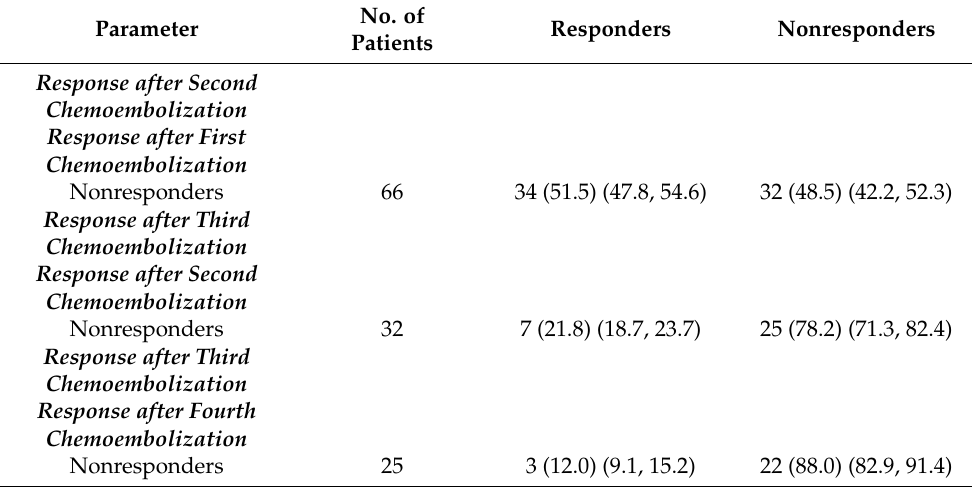
Table 2. Nonresponders to previous cTACEs after next cTACE sessions in the training cohort.